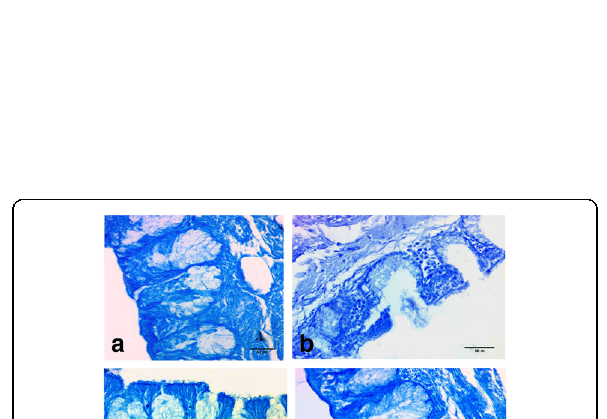
Fig. 13 Photomicrograph of a transverse section of common moorhen. a Transitional epithelium with cilia (arrow) and compound-branched alveolar gland (star). b Transitional epithelium (Te) covers the vomer bone (V). (H& E)